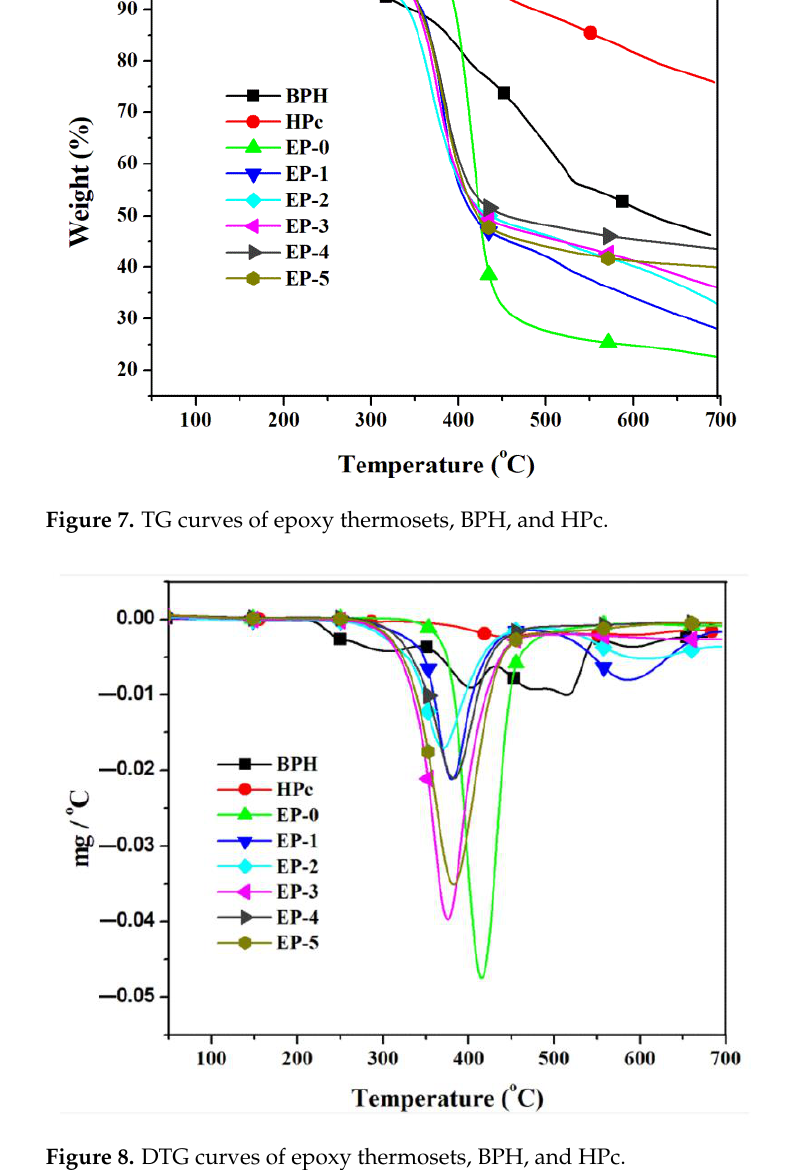
Figure 8. DTG curves of epoxy thermosets, BPH, and HPc.